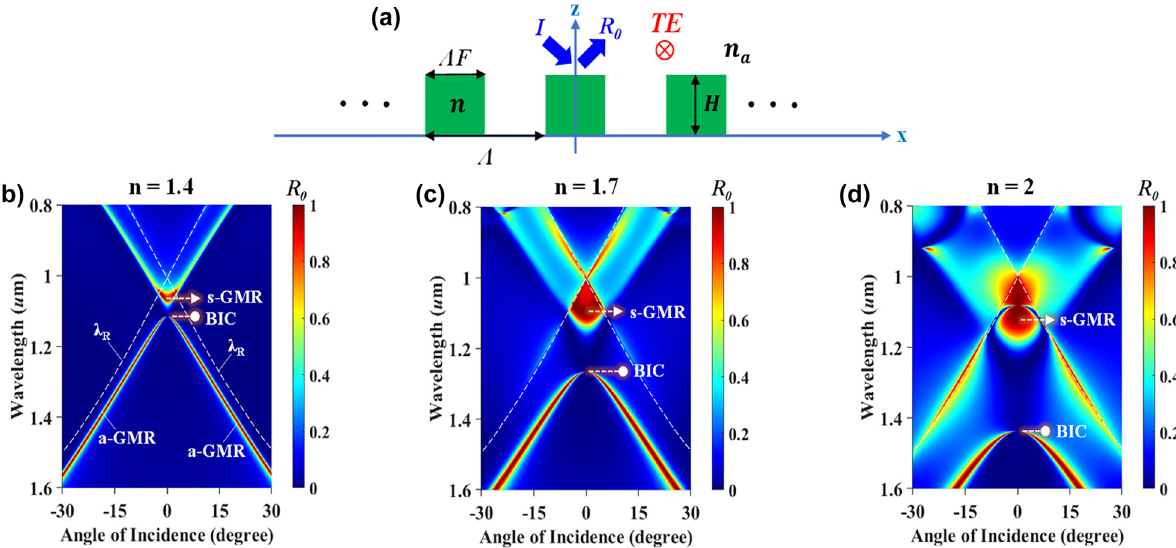
= 1). Parameters are period ( Λ = 1 μ m), grating a ( 𝜃 , 𝜆 ) properties are 0 ) is R